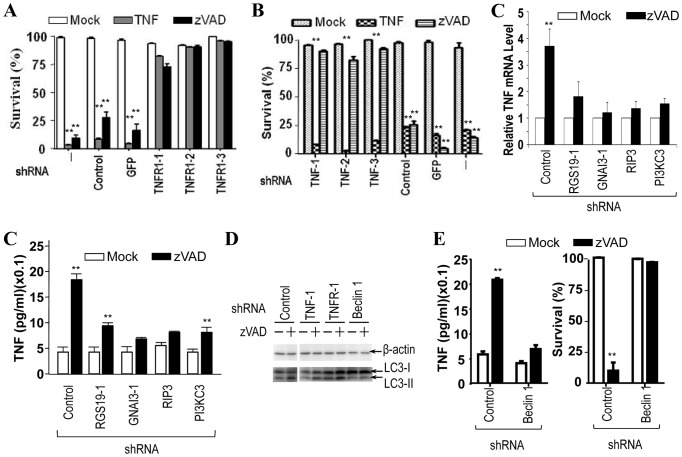
Blocking autophagy pathway inhibits zVAD-induced TNF production.(A) Knockdown of TNFR1 inhibited both TNF- and zVAD-induced cell deaths. Control and GFP- or TNFR1-knockdown L929 cells were treated with mock, TNF (10 ng/ml) or zVAD (20 µM) for 24 h. Then cell viabilities were measured. (B) Knockdown of TNF inhibited zVAD- but not TNF-induced cell death. Control and GFP- or TNF-knockdown L929 cells were treated with mock, TNF (10 ng/ml) or zVAD (20 µM) for 24 h. Then cell viabilities were measured. (C) Knockdown of RGS19, GNAI3, RIP3, or PI3KC3 all inhibited zVAD-induced increase of TNF mRNA. Control and RGS19-, GNAI3-, RIP3- or PI3KC3-knockdown L929 cells were treated with mock or zVAD (20 µM) for 3 h. TNF mRNA levels were measured by real-time PCR. (D) Knockdown of RGS19, GNAI3, RIP3, or PI3KC3 all inhibited zVAD-induced TNF secretion. Control and RGS19-, GNAI3-, RIP3- or PI3KC3-knockdown L929 cells were treated with mock or zVAD (20 µM) for 24 h. Then the cell culture medium was collected and concentrated 10 folds, and the TNF secretion was determined by ELISA. (E) Beclin-1, but not TNF or TNFR1, is required for zVAD-induced LC3 modification. Control and TNF-knockdown or TNFR-knockdown or Bclin 1-knockdown L929 cells were treated with mock or zVAD (20 µM) for 12 h. Cell lysates were subjected to Western blot analysis with antibodies against LC3 and β-actin. (F) Control and Bclin 1-knockdown L929 cells were treated with mock or zVAD (20 µM) for 12 h. Then TNF secretion was determined (left) and cell viabilities were measured (right). **, p<0.01.